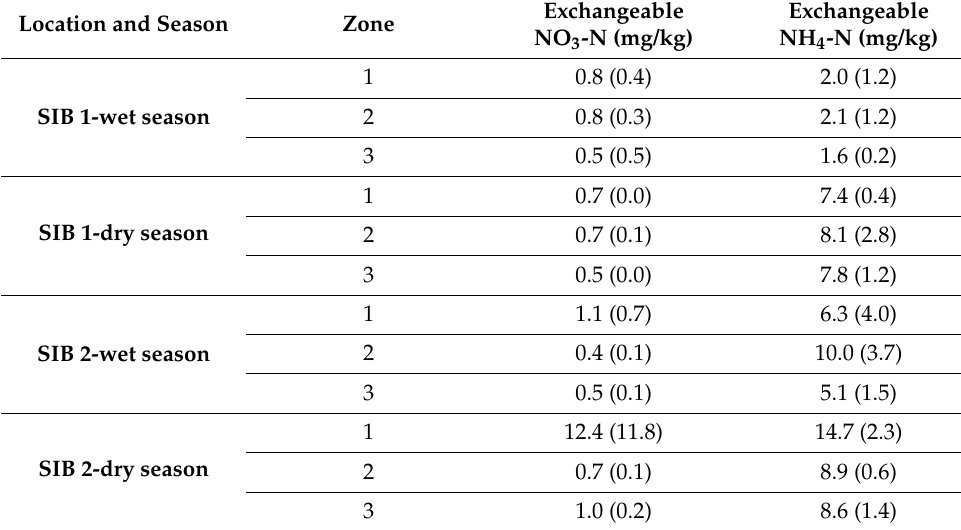
Table 2. Mean exchangeable inorganic N pools ( ± standard error) in SIB soils at the 0–30 cm depth in the wet and dry season and in the 3 sediment zones (Zone 1, frequently flooded; Zone 2, occasionally flooded; Zone 3, rarely